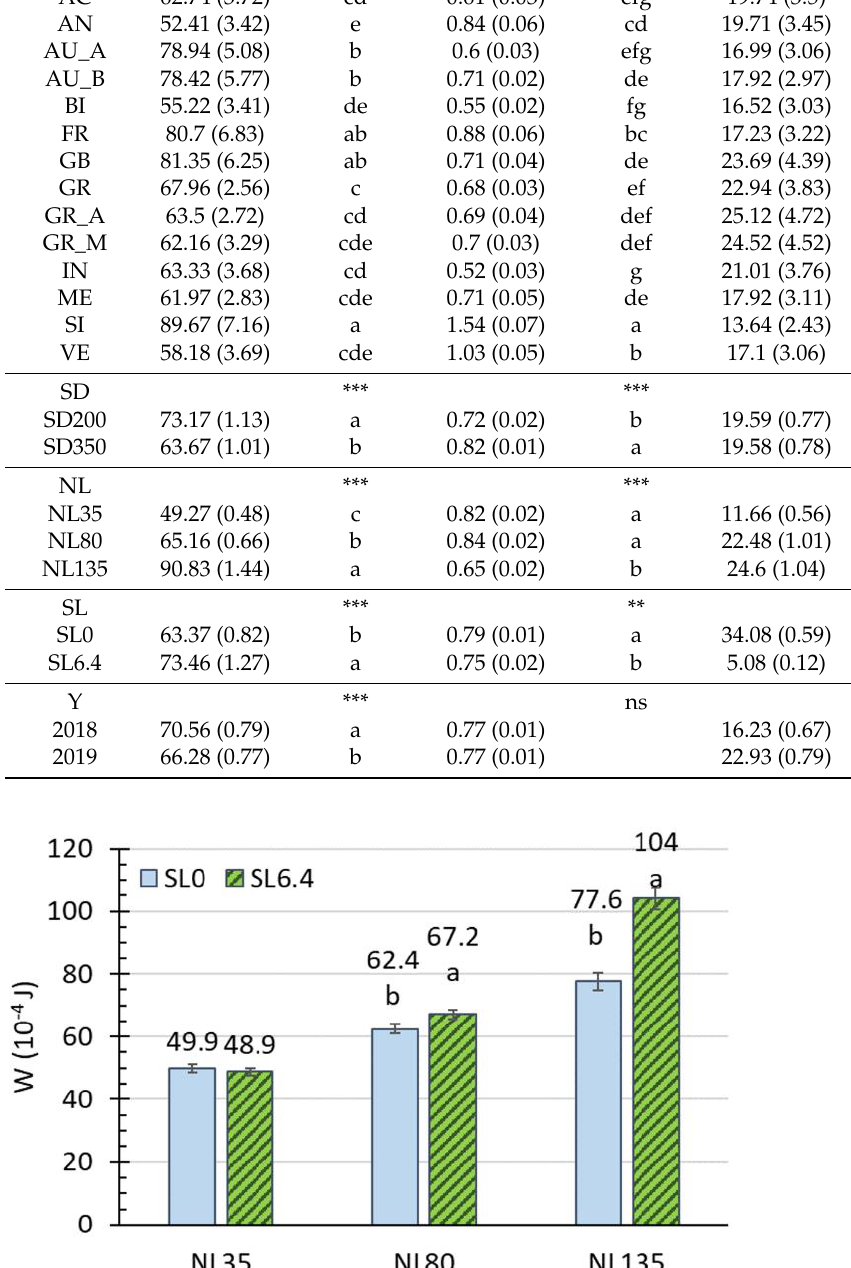
Figure 3. Effect of nitrogen fertilization level (NL) and sulfur fertilization level (SL) on dough strength (W). Lowercase letters represent the Tukey HSD post hoc test results. Table 6. Averages (standard error in brackets) of dough strength (W), the ratio between dough te- nacity and dough extensibility (P/L), and asparagine concentration in whole flour as a function of genotype (Gen), nitrogen (NL) and sulfur fertilization (SL), seeding density (SD), and first-order interaction. Lowercase letters represent the Tukey HSD post hoc test results. The table columns re- port the significance levels: ** = 0.01, *** = 0.001, ns = not significant. Variability Sources